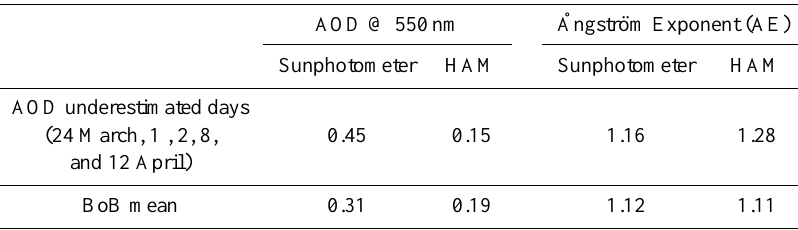
Table 5. Comparison of modelled AOD and ˚Angstr¨om Exponent (AE) with sunphotometer measured during missing dust source days and entire BoB